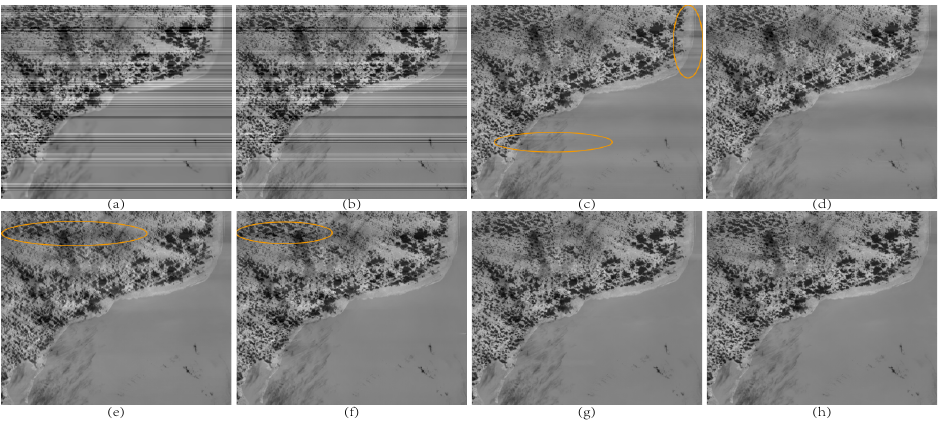
Figure 12. Comparison results for simulated stripe Aqua MODIS data S5. ( a ) BM3D; ( b ) SNRCNN;